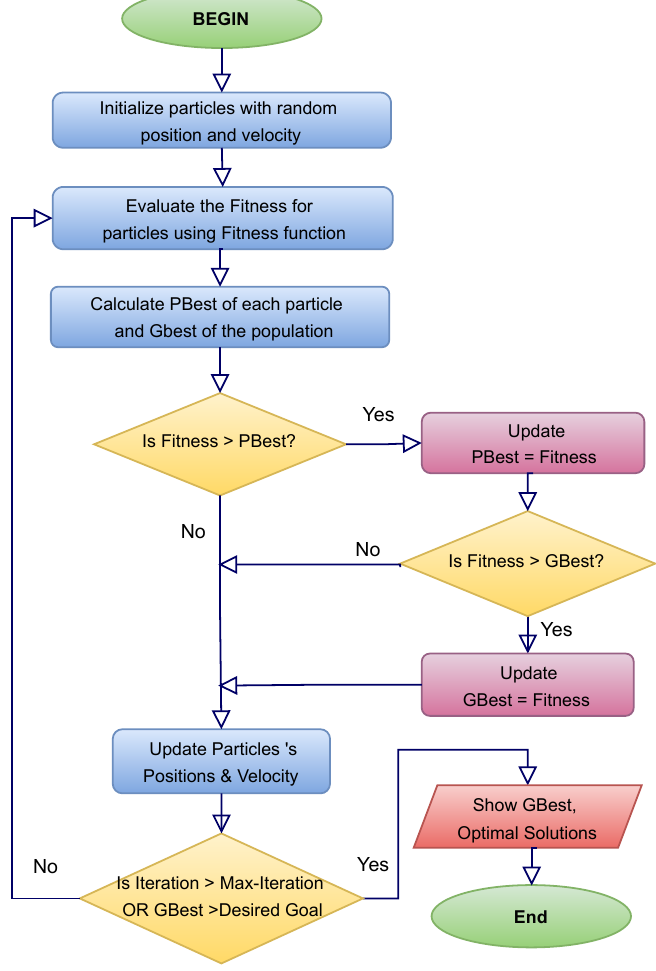
Figure 1. Flowchart of the general PSO